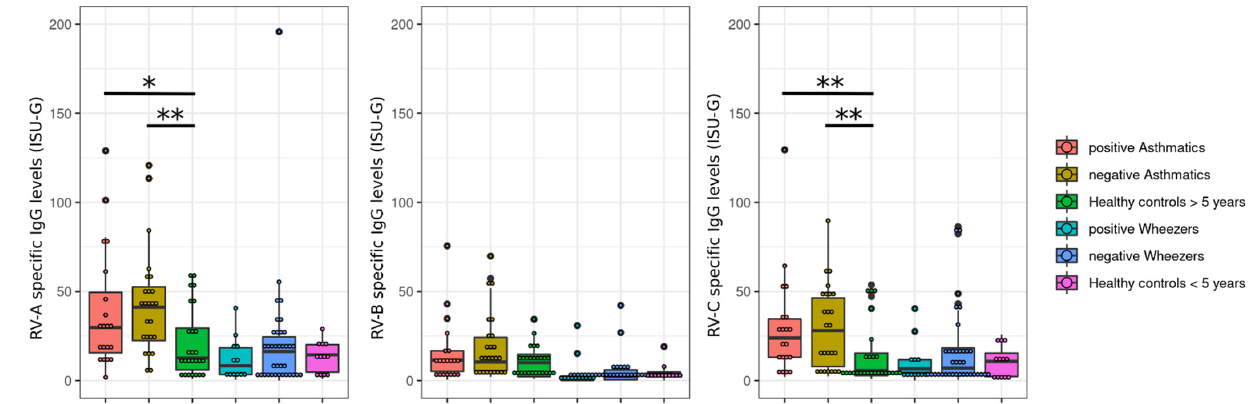
Figure 3. Steroid status does not significantly correlate with RV-specific IgG levels. RV-A, -B, and –C-specific IgG levels are expressed as ISAC standardized units ( y -axis: ISU-G) in asthmatics and wheezers, grouped according to the intake of corticosteroids or leukotriene receptor antagonist. Asthmatics and wheezers were subdivided between steroid-positive and steroid-negative patients. For each species and each age group, the virus-specific antibody level of steroid-positive patients, steroid-negative patients, and healthy controls were compared using Kruskal–Wallis tests. The p -values were corrected using the FDR method. Significant differences were found in participants older than five years old for A- ( p = 0.030) and C-species ( p = 0.020). Post-hoc pairwise comparisons (Mann–Whitney U tests) found in each case significant differences between both groups of asthmatics and healthy controls, but no significant differences between steroid-positive and steroid-negative asthmatics or wheezers were found (Positive: Steroid-positive. Negative: Steroid-negative; *: 0.01 < p < 0.05; **: 0.001 < p < 0.01).